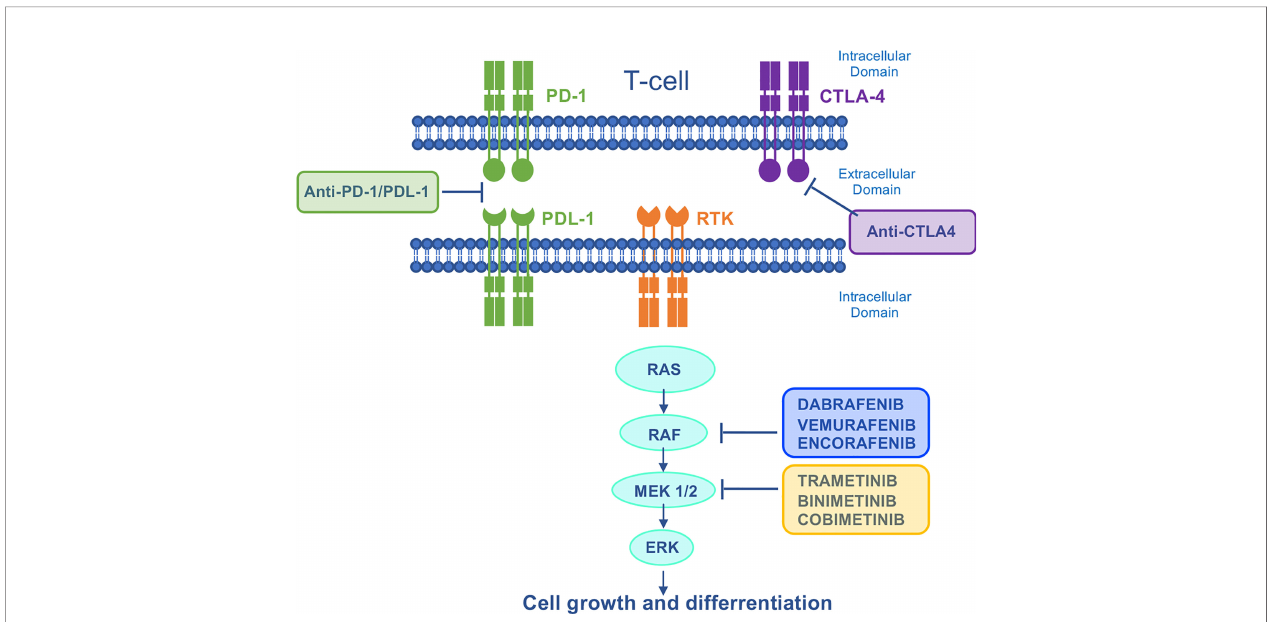
FIGURE 5 | Mechanism of action of MAPK – targeted drugs and immunotherapies. The Ras/Raf/MEK/ERK signaling pathway is activated by several upstream receptor tyrosine kinases. Dabrafenib, vemurafenib and encorafenib are speci fi c BRAF – inhibitors used in the treatment of BRAF – mutant melanoma. In a strategy to vertically target the MAPK signaling pathway, they are used in combination with trametinib, cobimetinib, and binimetinib respectively. Immune checkpoint blockade inhibits the negative regulation of T cell activation, thereby unleashing antitumor T – cell responses. CTLA4, cytotoxic T – lymphocyte antigen 4; PD1, programmed cell death protein 1; PDL – 1, programmed death ligand 1; RTK, receptor tyrosine